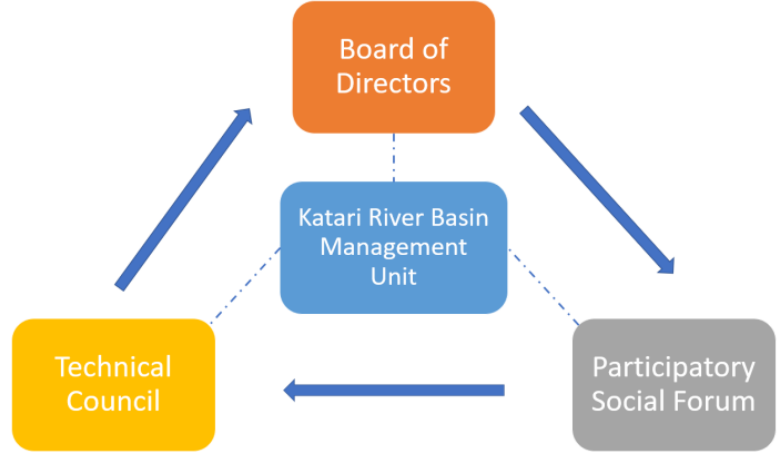
Figure 3. Katari River Basin platform’s organizational structure, from [23].